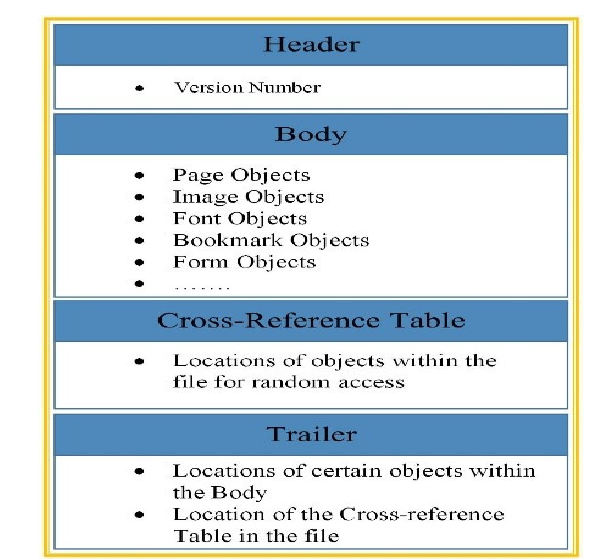
Fig. 3: The basic structure of PDF File [33] The keyword “xref” indicates the beginning marks, the list starts at object 0, and the next number is a count of cross-reference table objects. The Trailer is used to find the cross-reference table. Each object is linked with that table which acts as a dictionary. The example of a PDF file syntax object is given in Fig. 5, where a unique number is starting with “obj” to